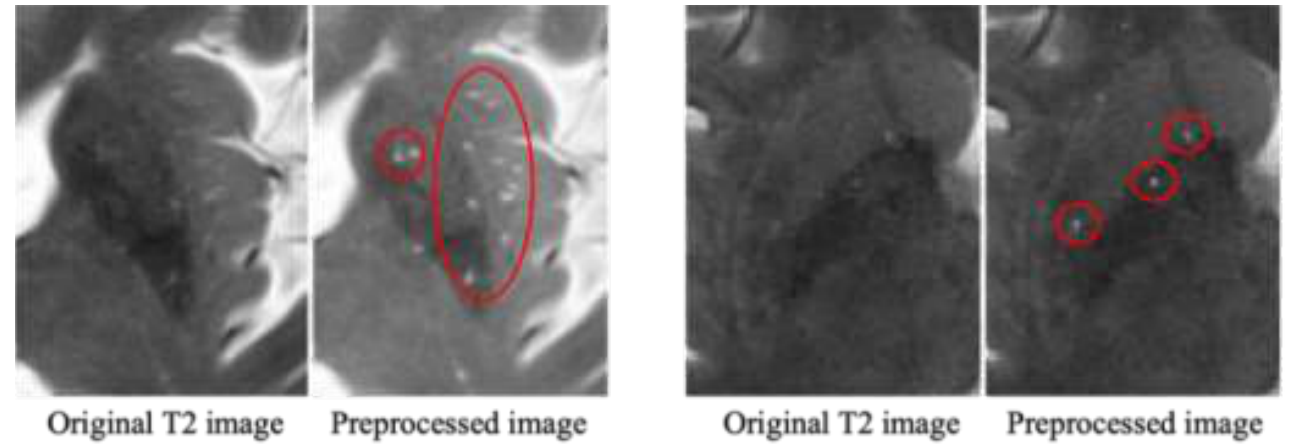
Figure 2. The comparison of EPVS in originally cropped image ( left ) and the image after applying the Haar-transformation ( right ) on T2-weighted MRI scans in the basal ganglia region of selected subjects (We can observe that the EPVS (circled in red) are enhanced and have better visibility after preprocessing).